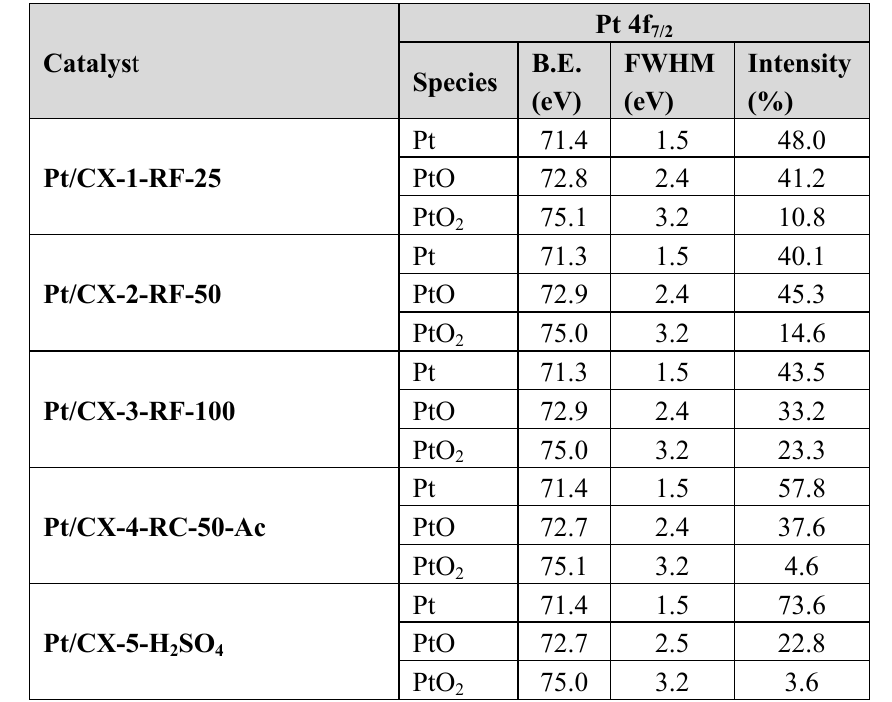
signal for the different catalysts 7/2